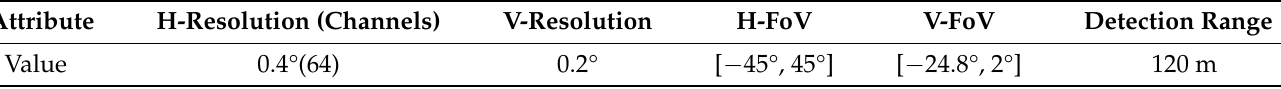
Figure 7. The demos of ShapeKITTI (blue boxes indicate the bounding boxes of newly added objects). Table 1. The configurations of the virtual scanning